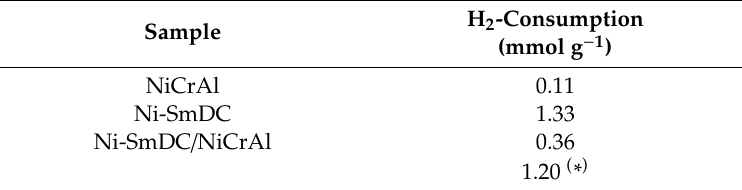
Figure 5. Temperature programmed reduction (TPR-H2) profiles: ( a ) NiCrAl foam, ( b ) Ni-SmDC powder, ( c ) Ni-SmDC / NiCrAl structured catalyst. Table 3. Consumed hydrogen up to 800 ◦